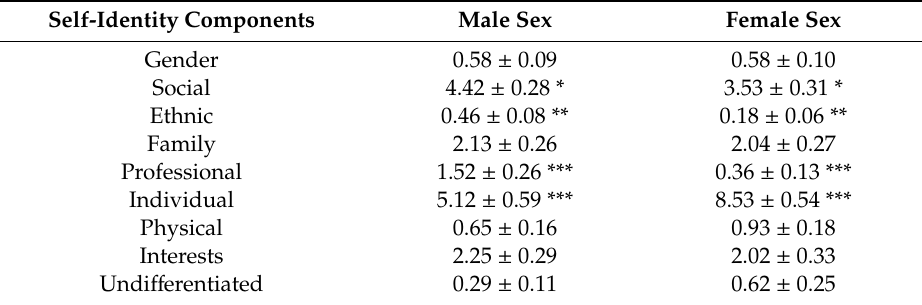
Table 3. Comparison of self-identity components among 12–15-year-old Nenets boys and